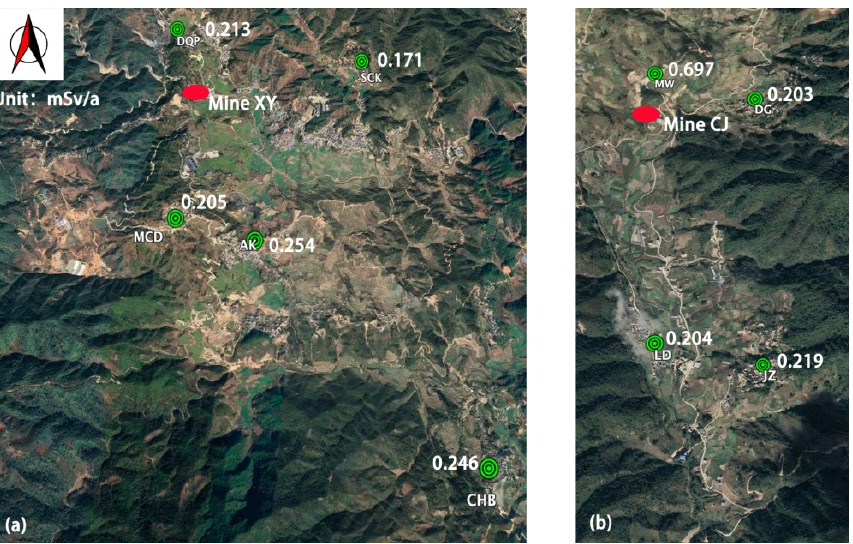
Figure 5. The ingestion doses estimated for adult residents living in the research area ( a ) villages around Mine XY; ( b ) villages around Mine CJ.